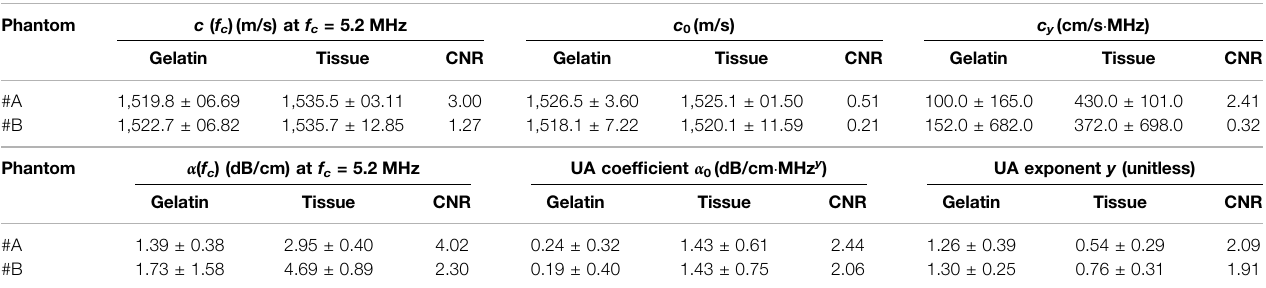
TABLE 2 | Quantitative evaluation of SoS and UA model parameter reconstructions for ex-vivo experiments.